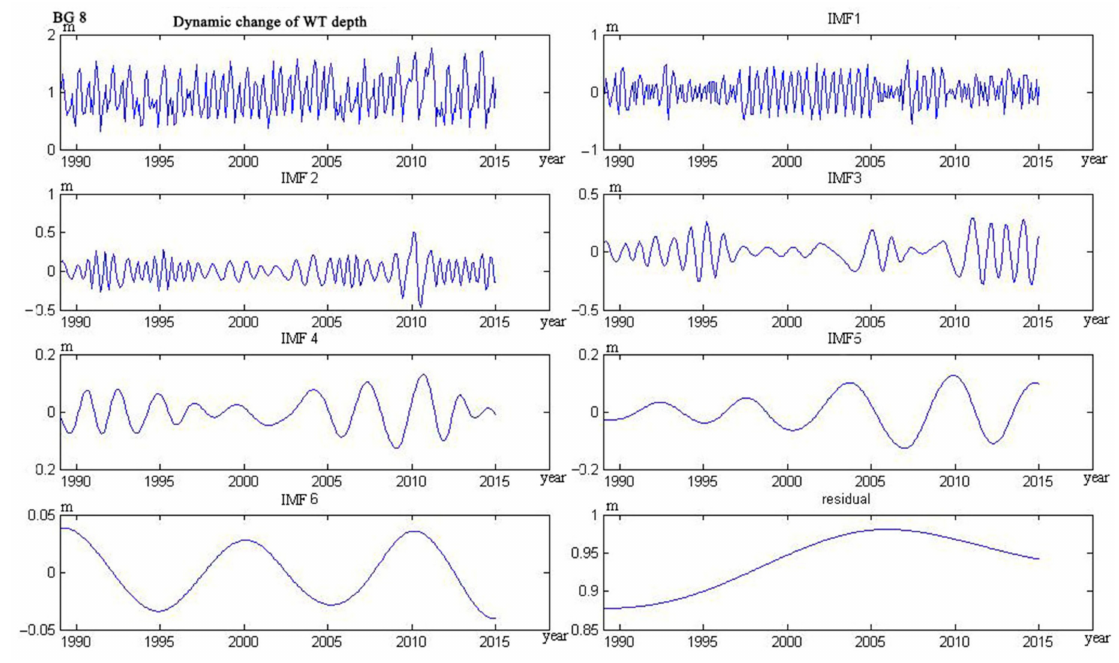
Figure A6. Decomposition of groundwater time series data of well